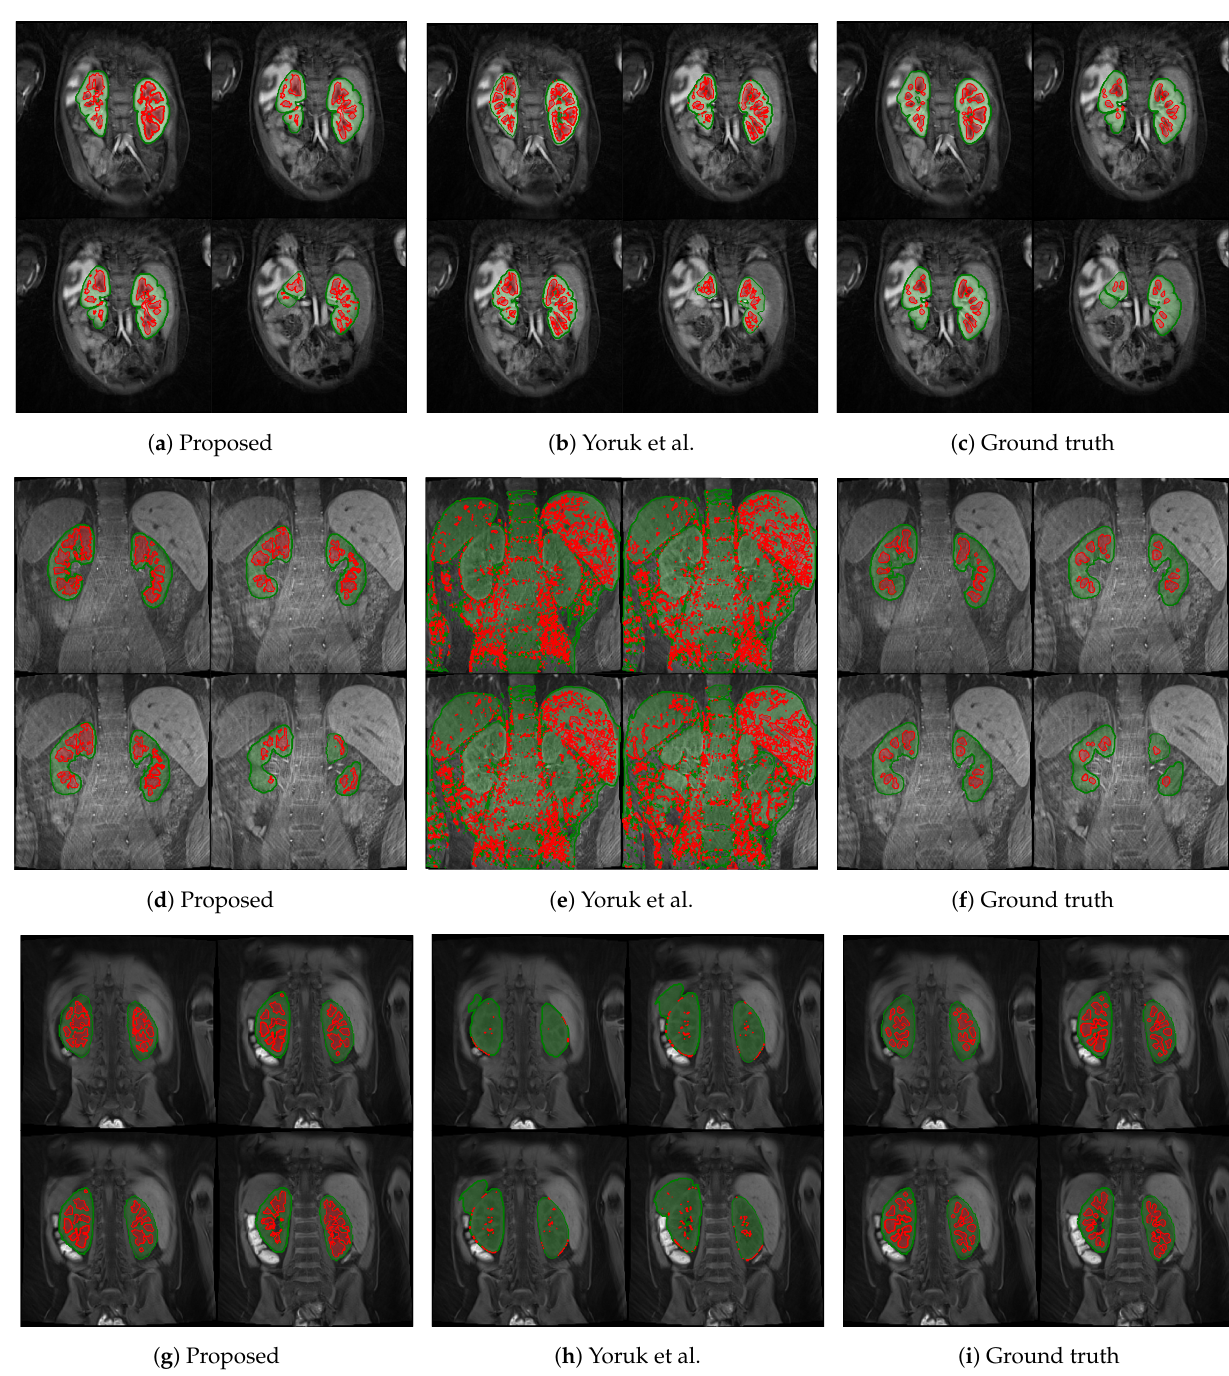
Figure 5. Medulla and cortex segmentation results of three different clinically ”normal” kidneys. The first column ( a , d , g ) shows the results from the proposed approach; the second column ( b , e , h ) shows the respective results using the baseline approach from Yoruk et al. [16]; the third column ( c , f , i ) shows the respective ground